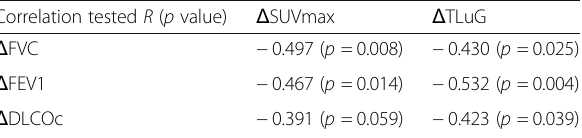
Table 3 Correlation of the change in SUVmax and TLuG with the change in lung function parameters, n = 27 Correlation tested R ( p value)